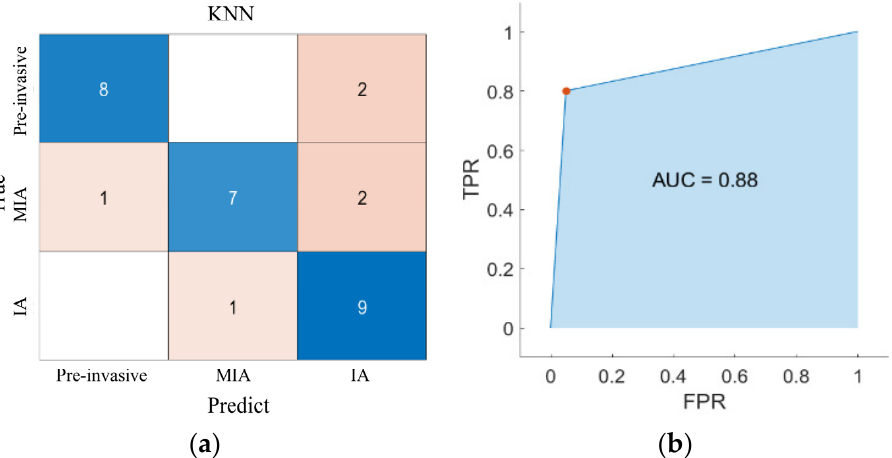
Figure 6. Experiments of the GGN subtype three-category classification with FFDC. ( a ) Confusion matrix; ( b ) ROC curve.